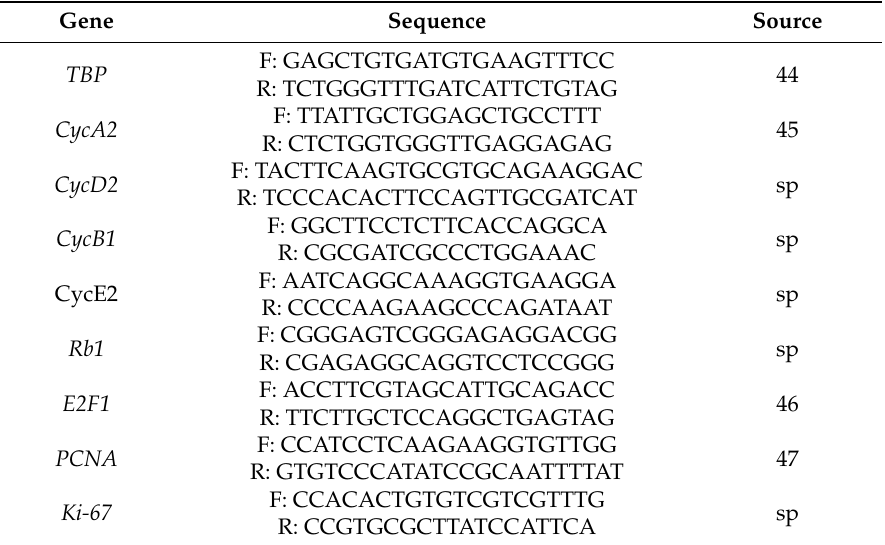
Table 2. Sequence of primers used in the qPCR